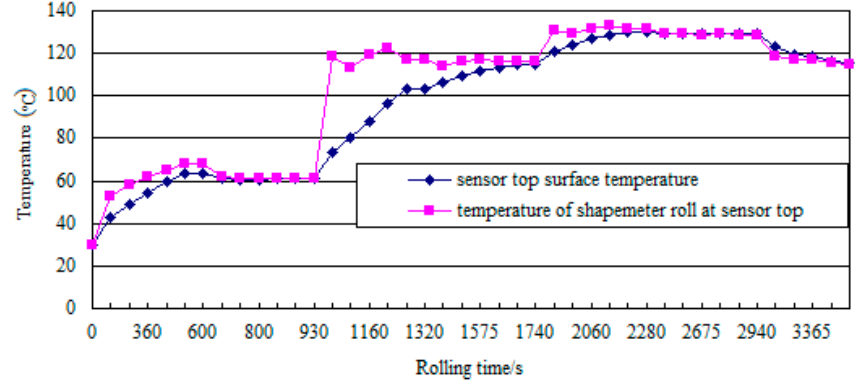
Figure 8. Temperature of the contact surfaces at the top of the sensor.